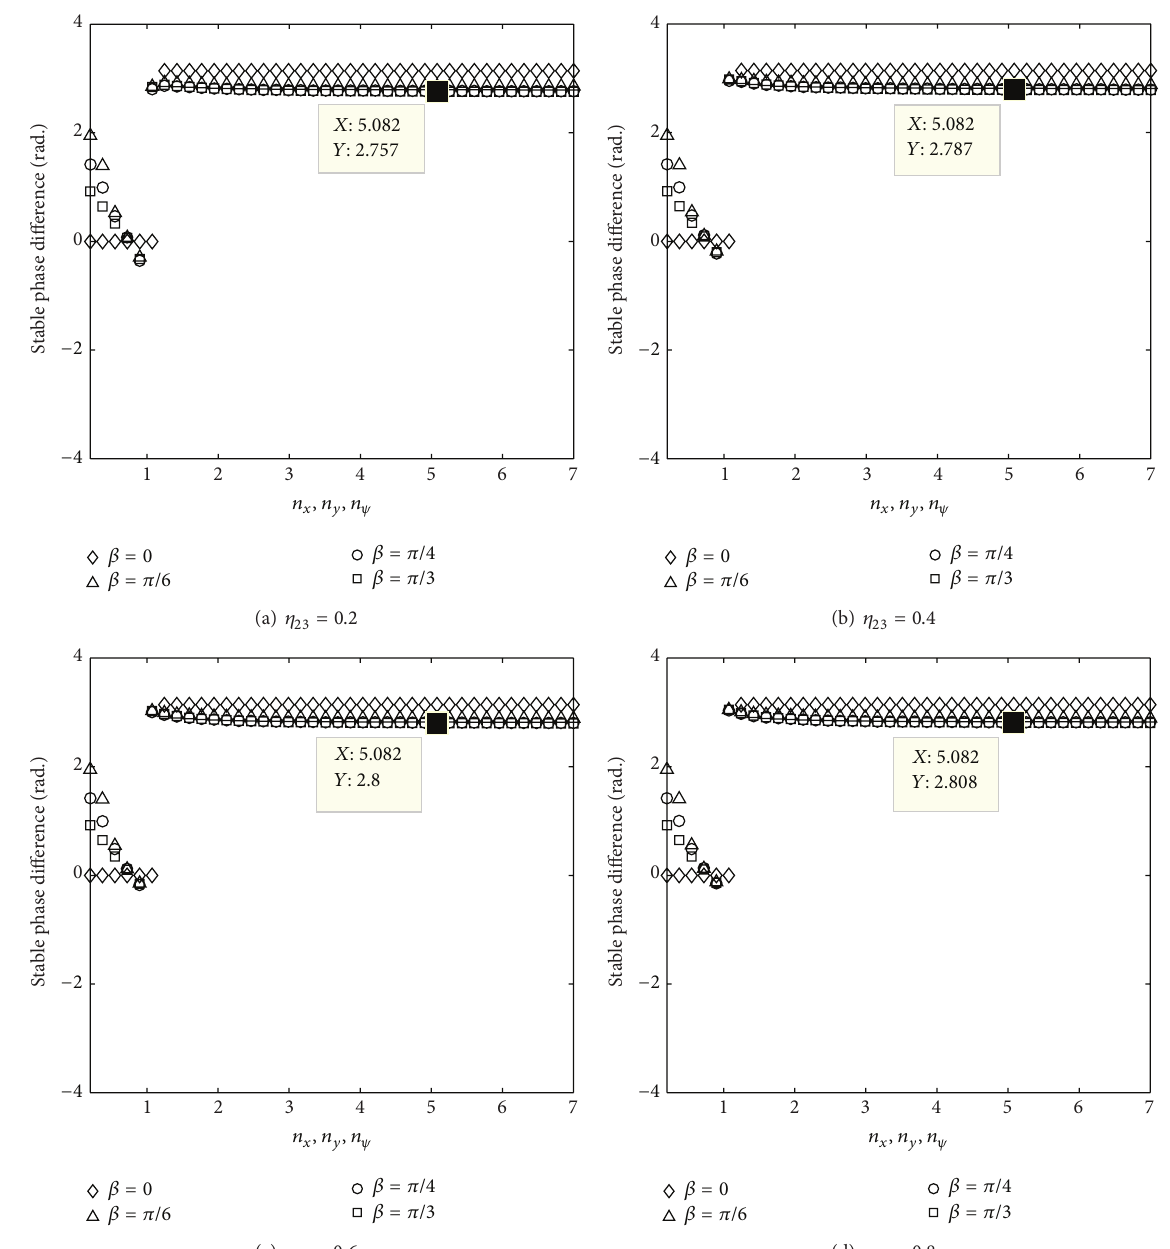
Figure 4: Stable phase difference for SBCWB and SACWB considering asymmetric mass of the rotors with 𝜂 13 = 5 , 𝑛 1 = 0.4 , 𝑟 𝑜 = 2 , 𝑟 𝑙 = 0.08 , and 𝑙 = 0.6 : (a) 𝜂 23 = 0.2 , (b) 𝜂 23 = 0.4 , (c) 𝜂 23 = 0.6 , and (d) 𝜂 23 = 0.8 .